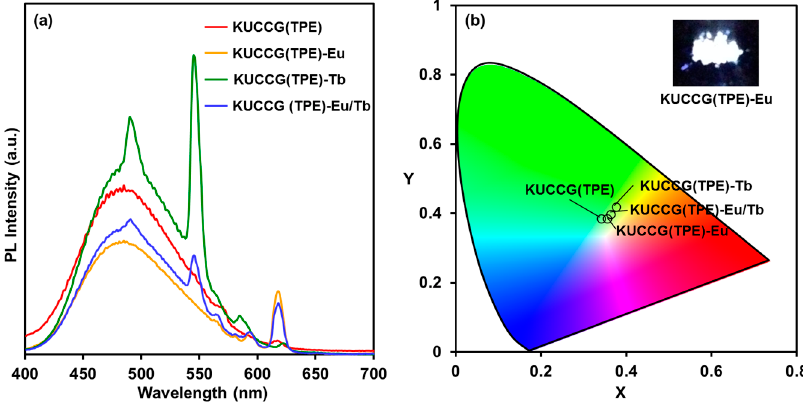
Figure 5. ( a ) Photoluminescence spectra of KUCCG(TPE), KUCCG(TPE)-Eu, KUCCG(TPE)-Tb, and KUCCG(TPE)-Eu/Tb ( λ ex = 280 nm); ( b ) CIE (Commission Internationale de L’Eclairage) 1931 (x,y) chromaticity diagram of KUCCG(TPE), KUCCG(TPE)-Eu, KUCCG(TPE)-Tb, and KUCCG(TPE)- Eu/Tb from the fluorescence spectra.